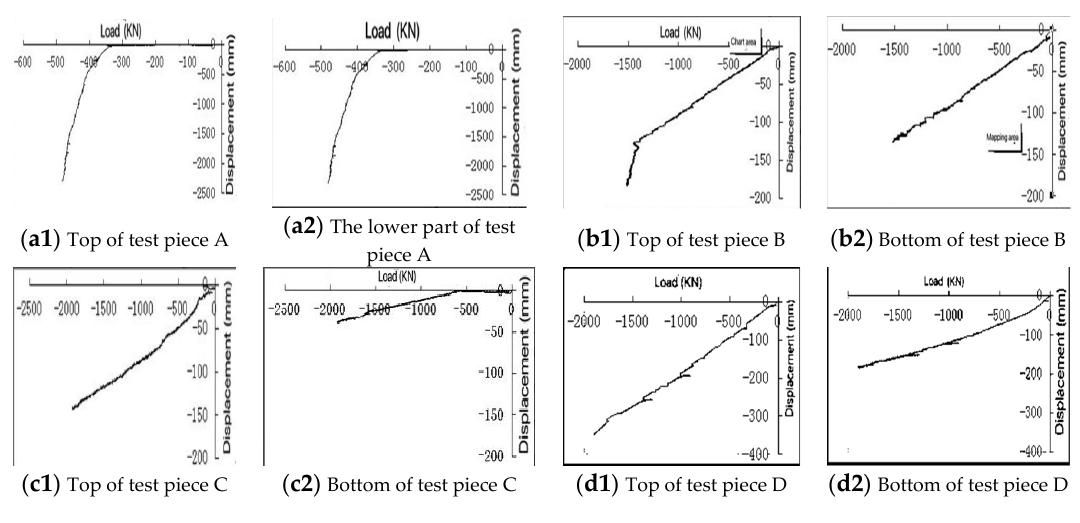
Figure 4. Load-settlement curves.